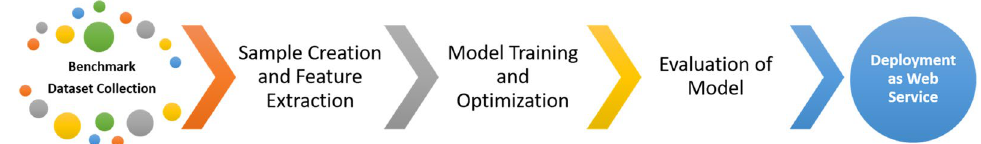
Figure 1. Proposed stepwise approach.